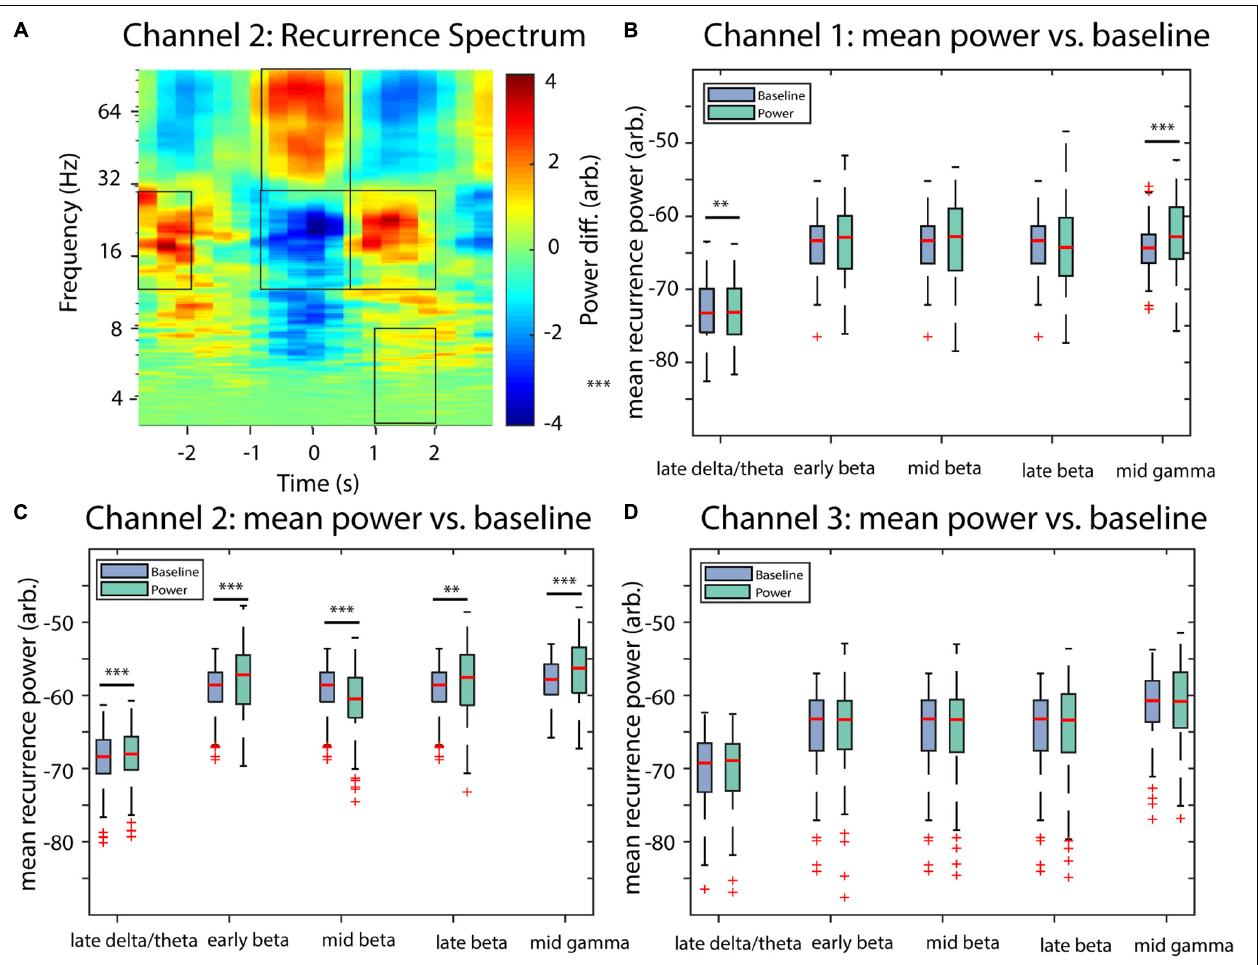
FIGURE 12 | Statistical comparisons of recurrence amplitudes with baseline activity of invasive recordings. (A) An example recurrence amplitude plot, indicating the time-frequency intervals extracted for statistical analysis. (B) Statistical comparisons for Channel 1 (two-sided paired Student’s T -test, Bonferroni corrected). (C) Statistical comparisons for Channel 2. (D) Statistical comparisons for Channel 3. Asterisks indicate significant differences ( ∗∗ p < 0.01, ∗∗∗ p <